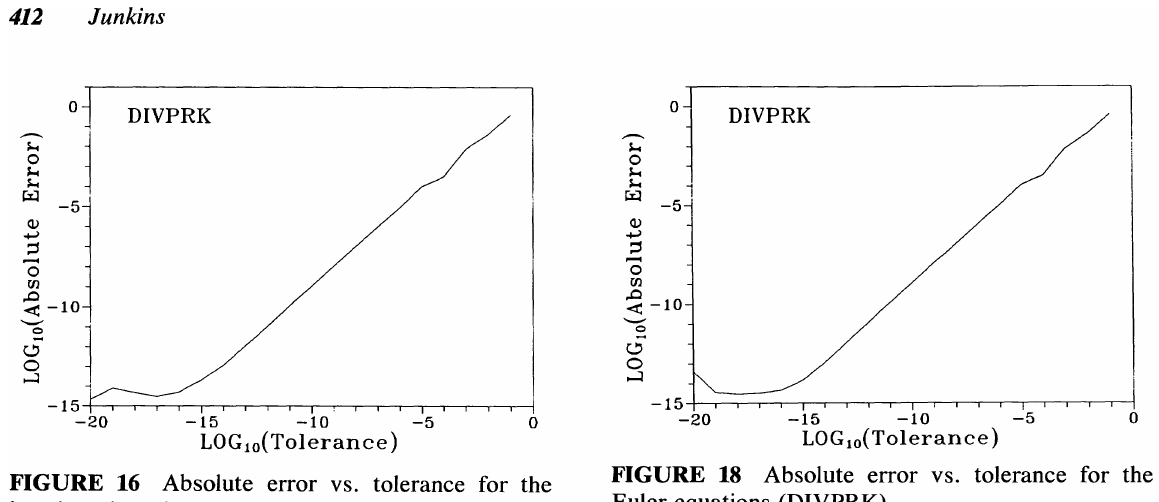
FIGURE 16 Absolute error vs. tolerance for the benchmark problem (DIVPRK).